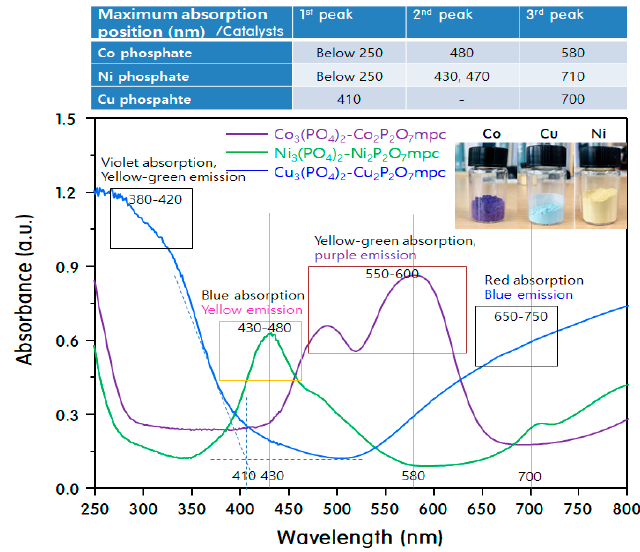
Figure 4. UV-Vis spectra of the M 3 (PO 4 ) 2 -M 2 P 2 O 7 mpc (M = Co, Ni, and Cu).